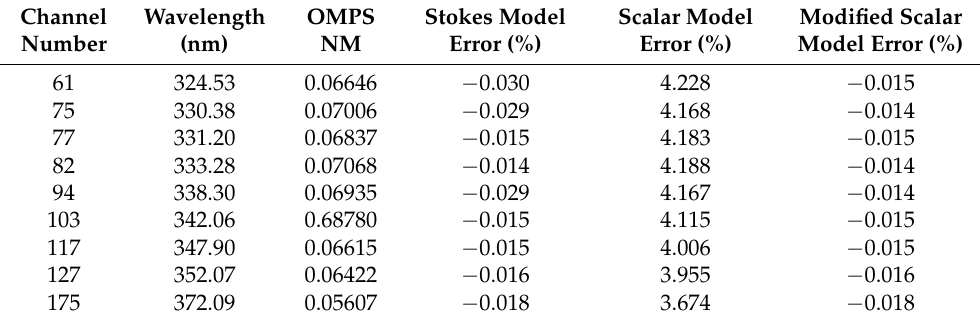
Table 2. Comparison of OMPS normalized radiance (OMPS NM) by solar irradiance with the CRTM Stokes, scalar, and modified scalar calculations. The land surface reflectance is interpolated or extrapolated from the surface reflectance at 347.6 nm and 371.8 nm. The latter two reflectance are calculated by fitting OMPS NM measurements at the two wavelengths. The scalar model uses the same surface reflectance as Stokes. The modified scalar model uses the surface reflectance by fitting the measurements with the scalar model calculations at the two